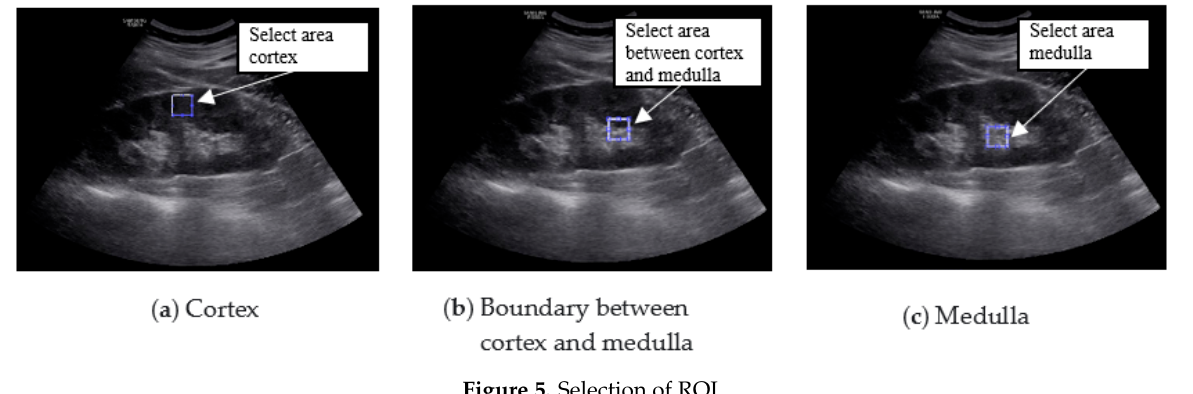
Figure 5. Selection of ROI.